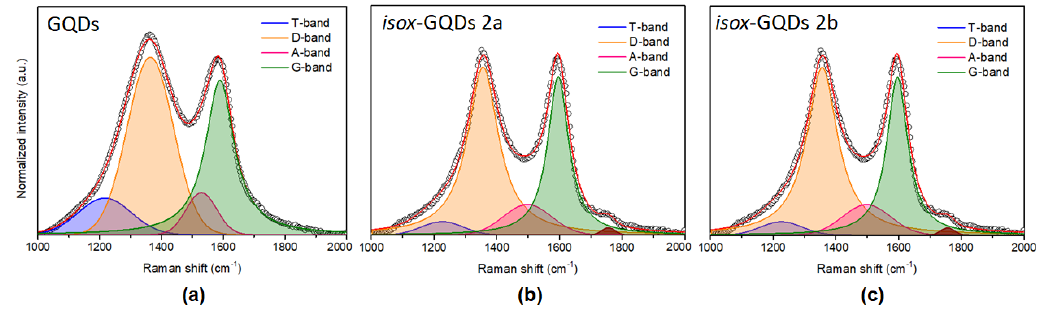
Figure 6. Raman spectra of: ( a ) GQDs, ( b ) isox -GQDs 2a and ( c ) isox -GQDs 2b .